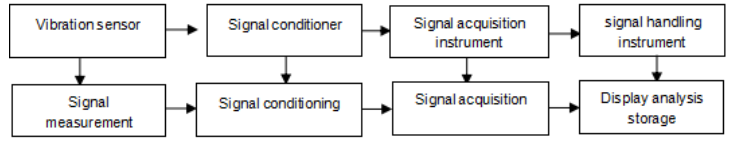
Fig. 1 Hardware composition diagram of the